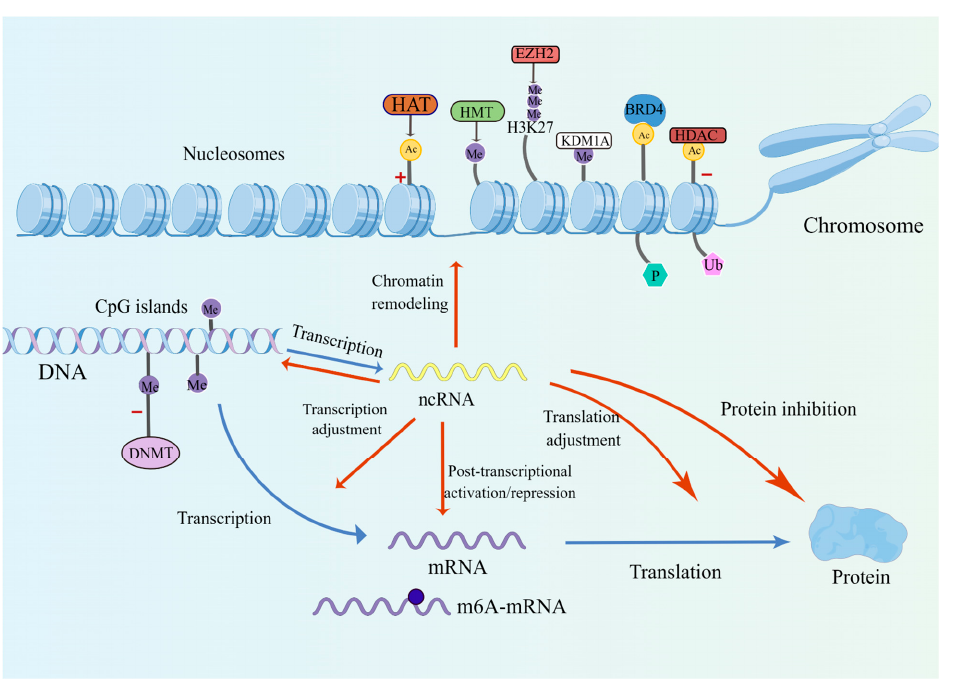
Figure 1. Epigenetic modi fi cations and relevant therapeutic targets in thyroid cancer. DNMT, DNA methyltransferase; Me, methylation; Ac, acetylation; HDAC, histone deacetylase; BRD4, bromo- domain-containing protein 4; KDM1A, lysine (K) demethylase 1A; EZH2, enhancer of zeste homo- log 2; HAT, histone acetyltransferase; ncRNA, non-coding RNA; P, phosphorylation; Ub, ubiquiti- nation; +, promoting gene expression; − , inhibiting gene expression. Composed with Figdraw.